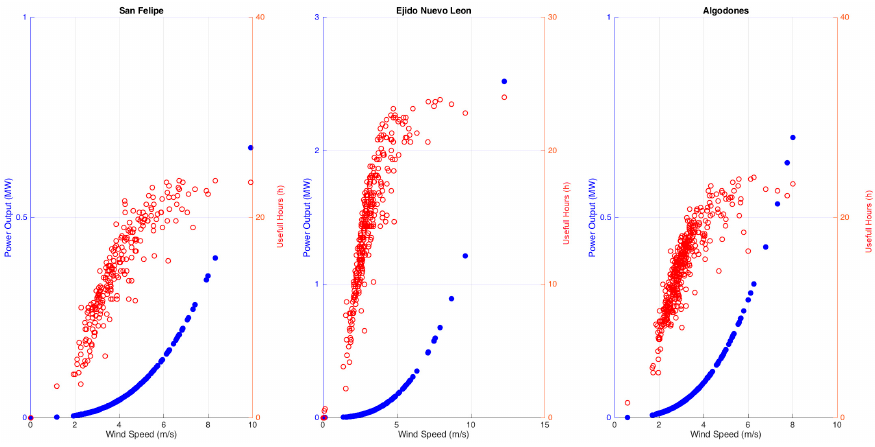
Figure 18. Power output, useful hours and wind speed by SAMs Baja California.